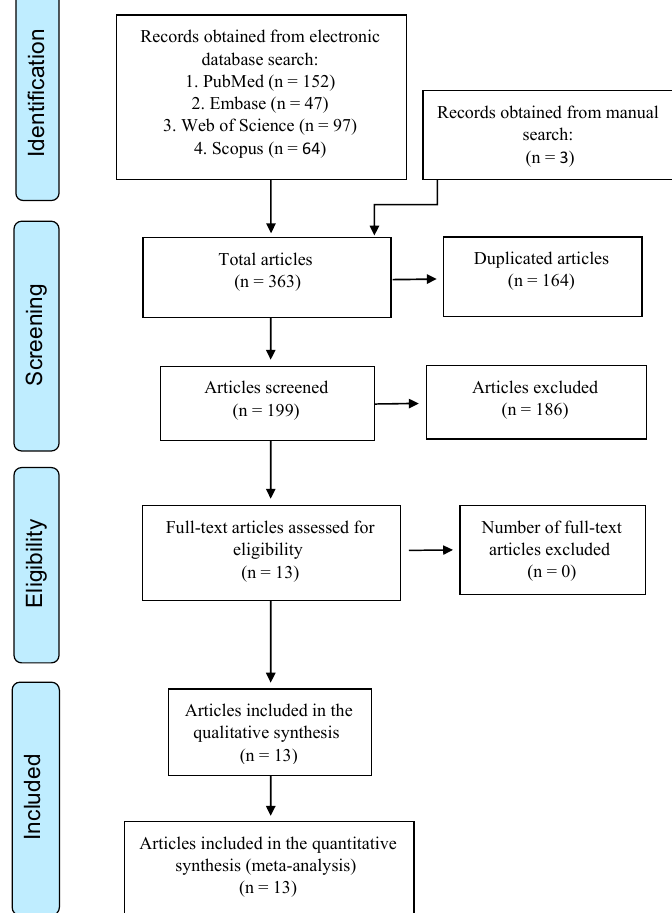
Figure 1. Preferred Reporting Items for Systematic Reviews and Meta-Analyses (PRISMA) flow di- agram.